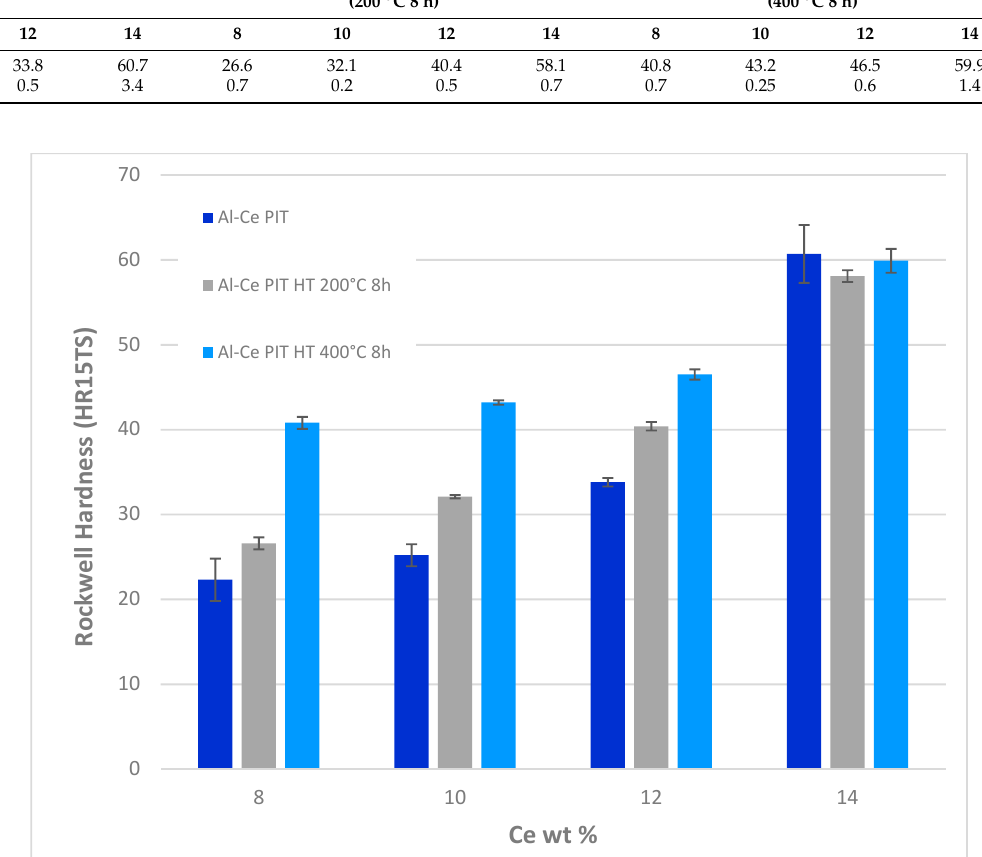
Figure 6. Effects of heat treatment on hardness of Al x Ce PIT reacted powder composites.